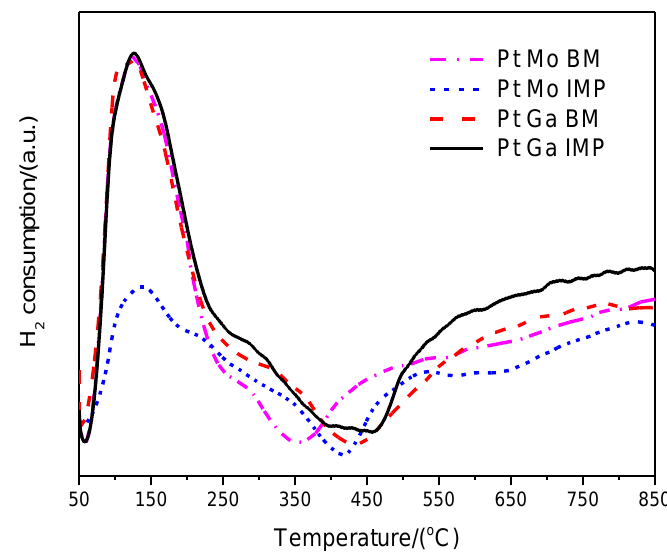
Figure 2. H 2 -temperature programmed reduction (TPR) profiles of Pt Mo BM, Pt Mo IMP, Pt Ga BM, and Pt Ga IMP samples.